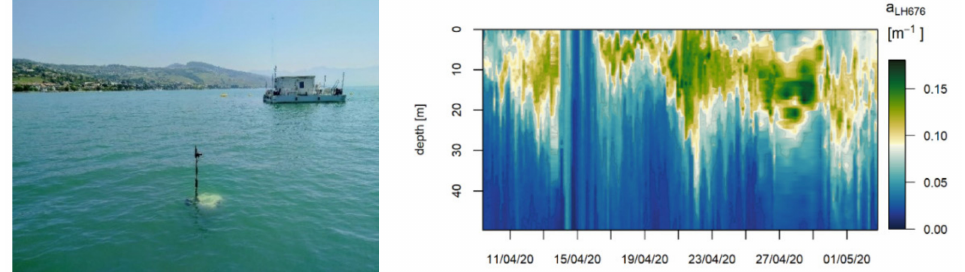
Figure 6. High resolution profiles of absorption line height peak at 676 nm measured between